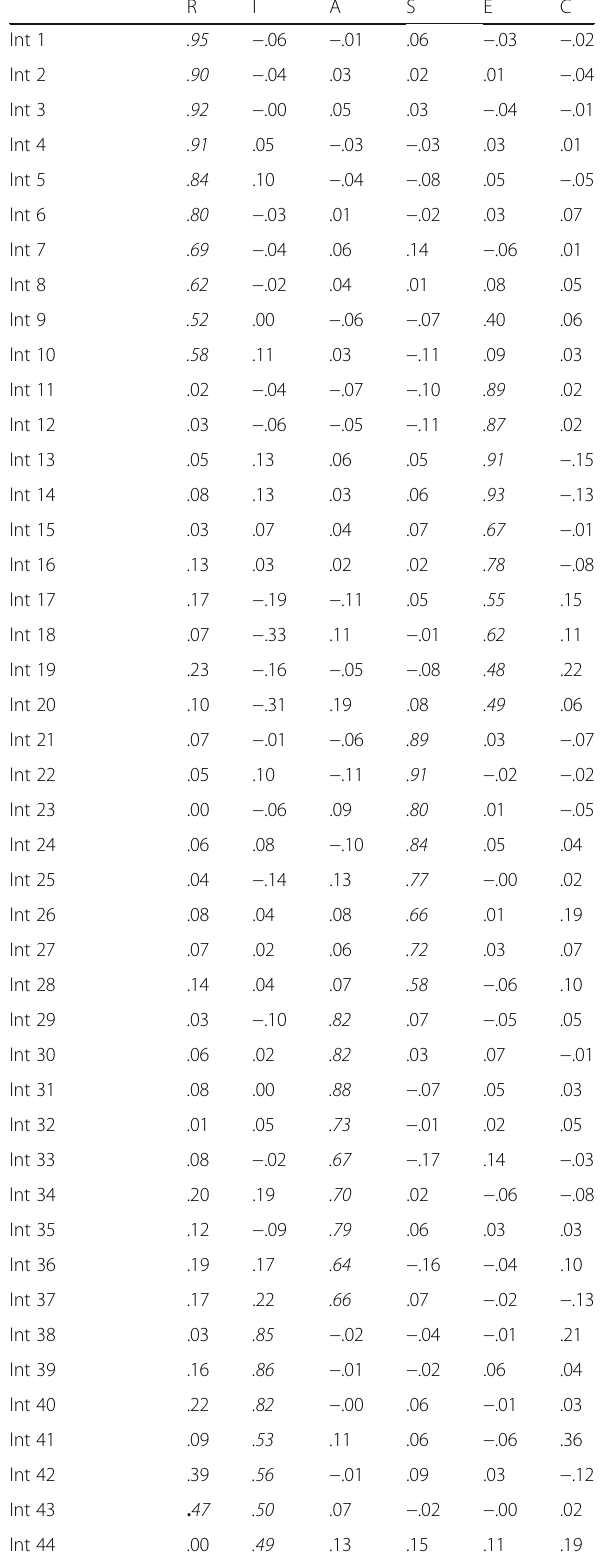
Table 1 WLSMV exploratory factor analysis of 54 initial item